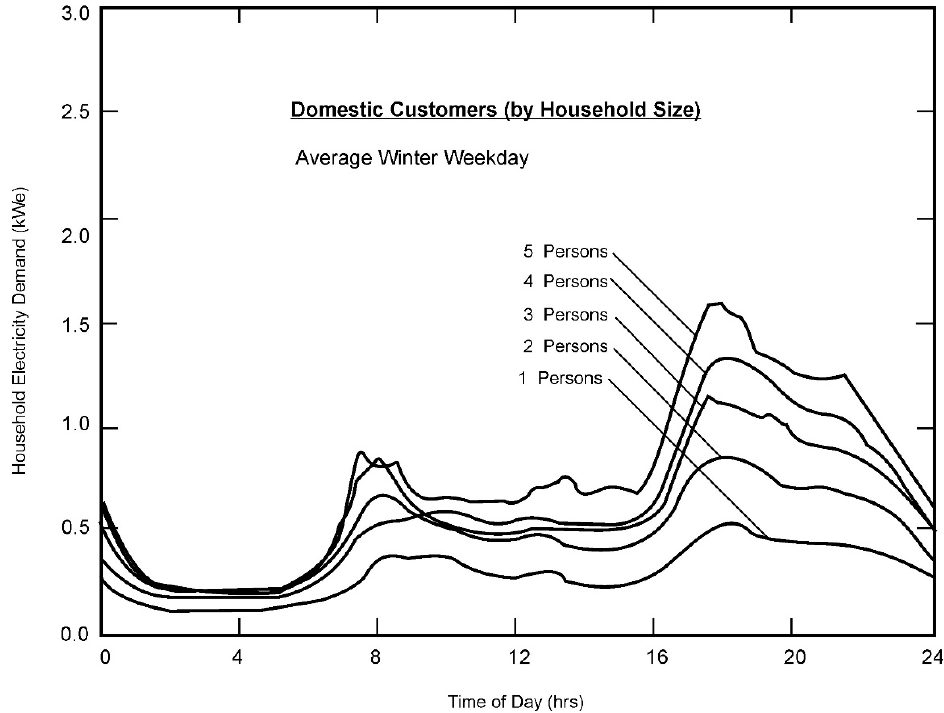
Figure 3. Measured UK winter domestic electricity load profiles by house size (number of occupants) . Source: Reprinted with permission from Ref. [18]. 2011, University of Nis—Faculty of Me-